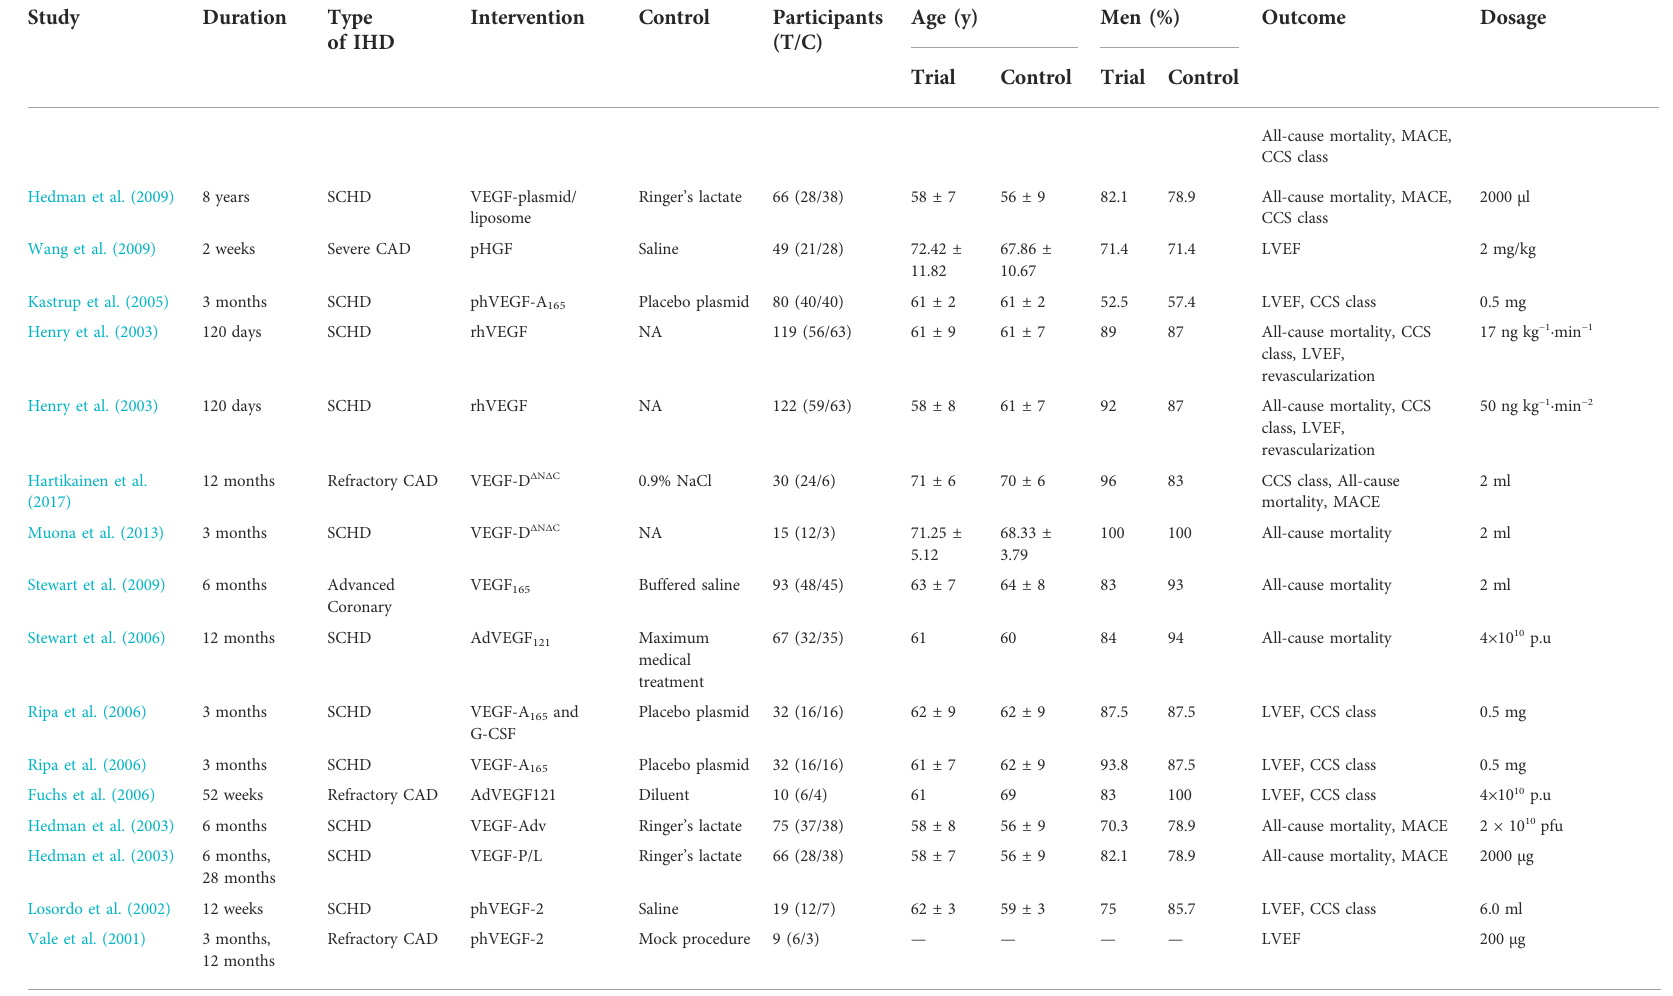
Abbreviations: T, trial; C, control; IHD, ischemic heart disease; CAD, coronary heart disease, STEMI, ST, segment elevation myocardial infarction; SCHD, stable coronary heart disease; MACE, major adverse cardiovascular events; PPCI, primary percutaneous coronary intervention; LVEF, left ventricular ejection fraction; CCS, canadian cardiovascular society; VEGF, vascular endothelial growth factor; EPO, erythropoietin; HGF, hepatocyte growth factor; G-CSF, granulocyte colony-stimulating